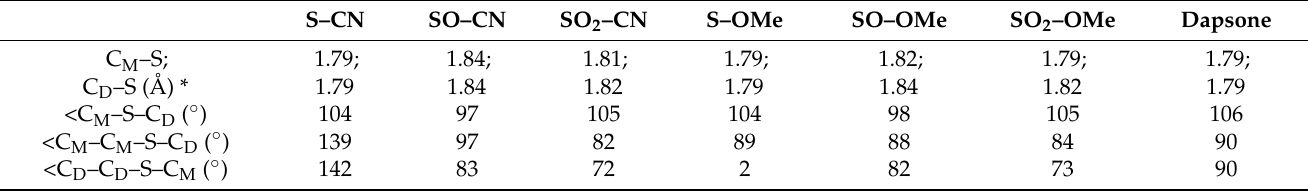
Table 2. Bond length, bond angle, and dihedral angle between sulfur atoms and sulfur-adjacent carbon atoms in the studied inhibitors. S–CN SO–CN SO 2 –CN S–OMe SO–OMe SO 2 –OMe